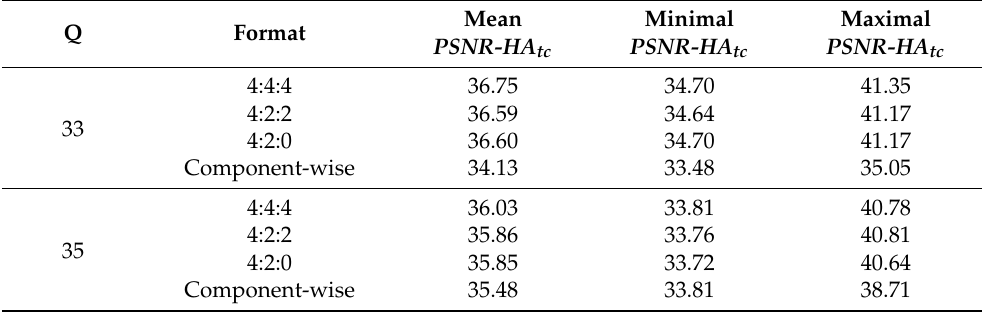
Table 5. Statistical data for comparison of compression variants’ performance characteristics ( PSNR-HA tc ).